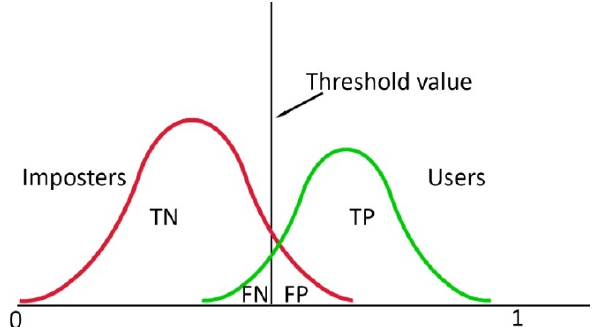
Figure 5. Visual representation of True Positive (TP) being the positive examples classified as positive, True Negative (TN) being the negative examples classified as negative, False Negative (FN) being the negative trials classified as positive, and False Positive (FP) being the positive trials classified as negative given the distributions of authorized individuals (green) and imposters (red).